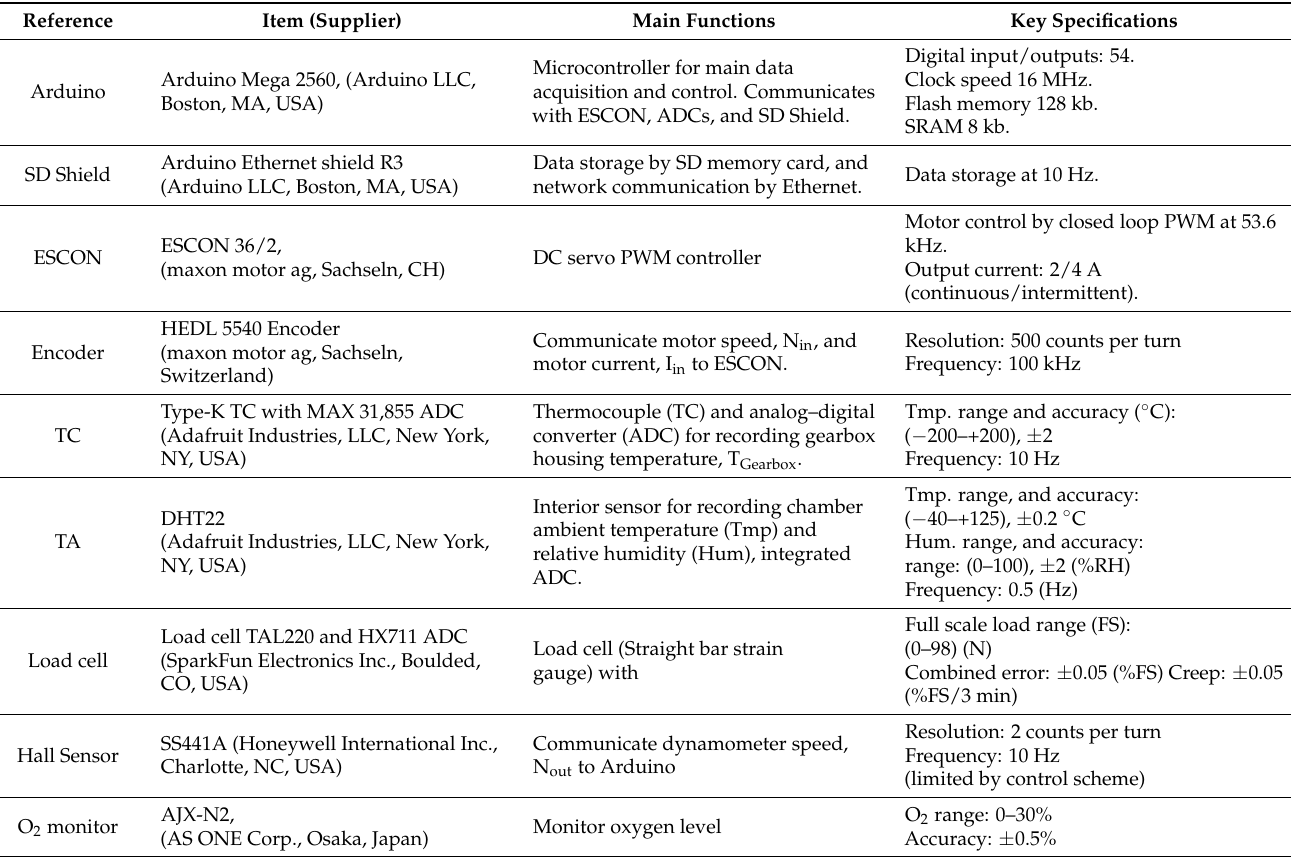
Table 1. Items composing the electronic control system and